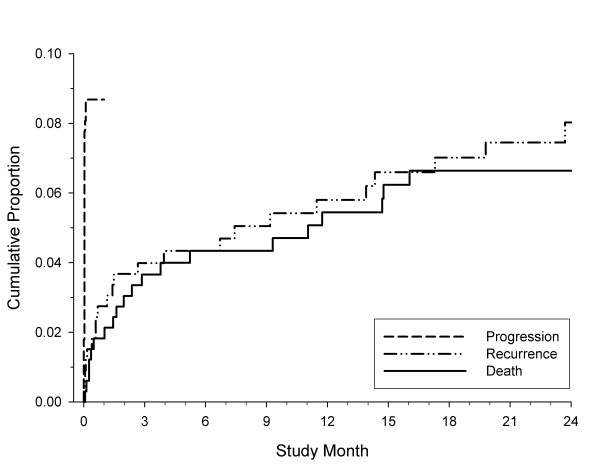
Kaplan-Meier cumulative failure curves for the outcome of progression, recurrence and death.